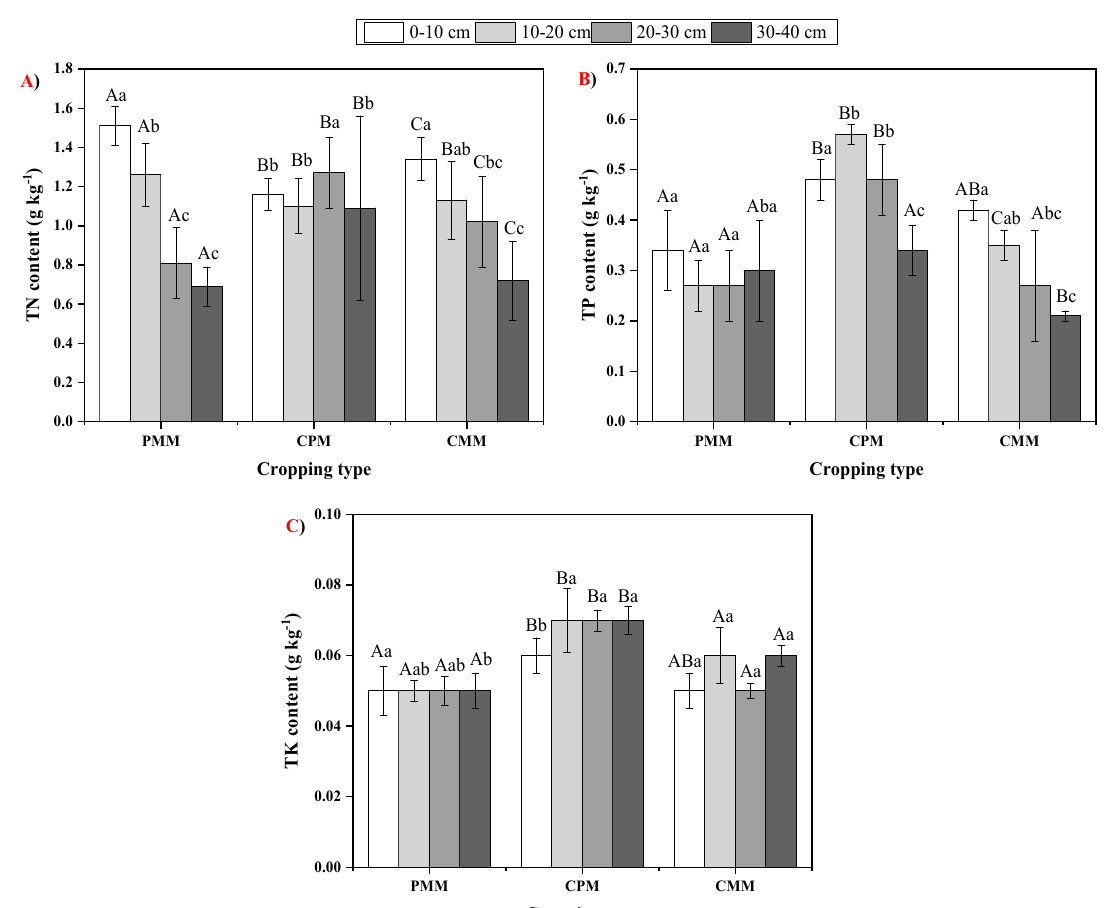
Figure 1. Variability in ( A ) soil total nitrogen (TN), ( B ) total phosphorus (TP) and ( C ) total potassium (TK) content at different soil depths in C. oleifera mono-cropping model (CMM), peanut mono-cropping model (PMM), and Camellia–peanut inter-cropping model (CPM). Two-way analysis of variance (ANOVA) test was conducted and the values in the columns are mean ± SD. Different uppercase letters indicate significant differences between the cropping systems at p < 0.05, while the different lowercase letters indicate significant differences among the soil depths p < 0.05.